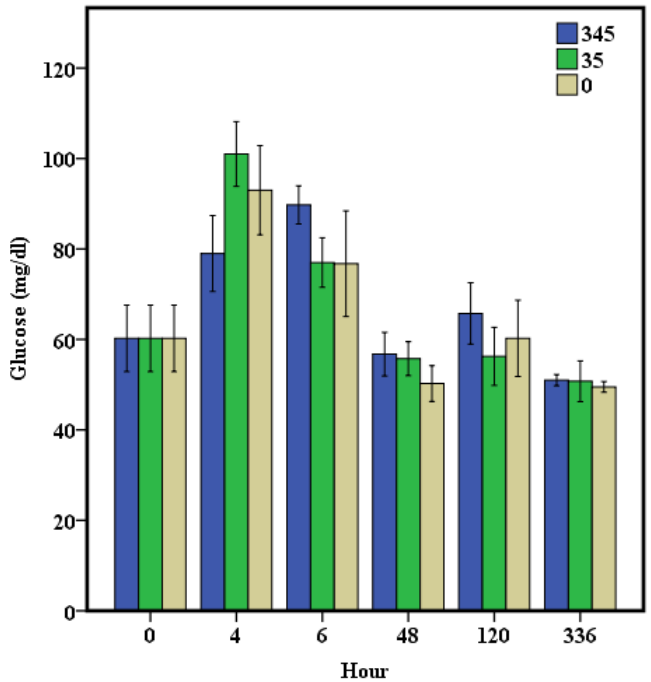
Figure 1. Trial 1 glucose levels (±SE) at the beginning (hour 0—before transfer, hardness of 345 mg/L) and 4, 6, 48, 120, and 336 hours after the start of the trial when rainbow trout Oncorhynchus mykiss ( n = 4 for each treatment at each timepoint) were directly transferred from 345 mg/L water hardness to experimental conditions without acclimation.